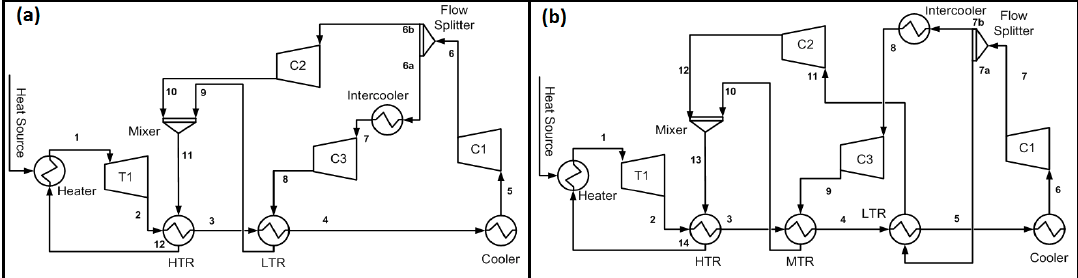
Figure 1. Supercritical CO 2 (S-CO 2 ) power cycle layouts: ( a ) recompression Brayton cycle (RBC) with partial cooling and ( b ) RBC with partial cooling and improved heat regeneration. LTR: low-temperature recuperator; HTR: high-temperature recuperator. Layouts ( a ) adapted from [17].